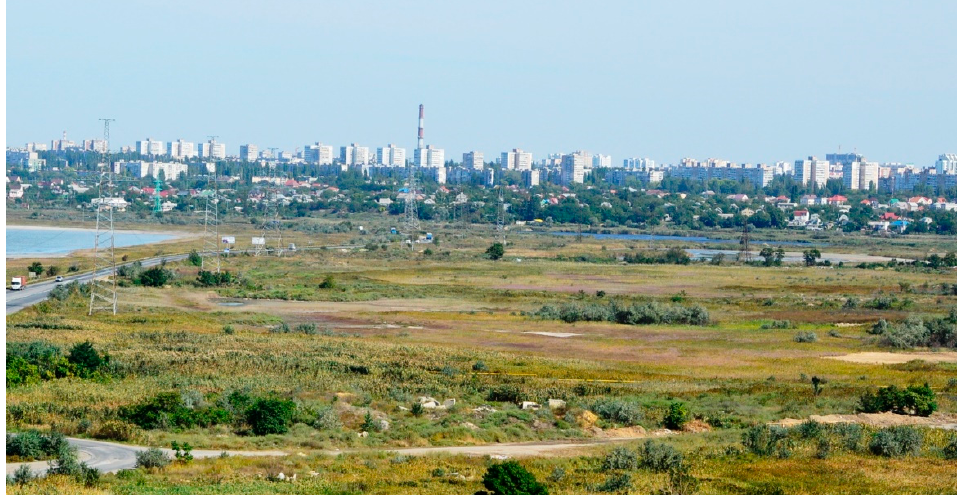
Figure 14. The built-up (the village of Kotovskyi (Odesa)) and meliorated (artificial ponds) part of the lower valley of Kuyalnik Estuary.